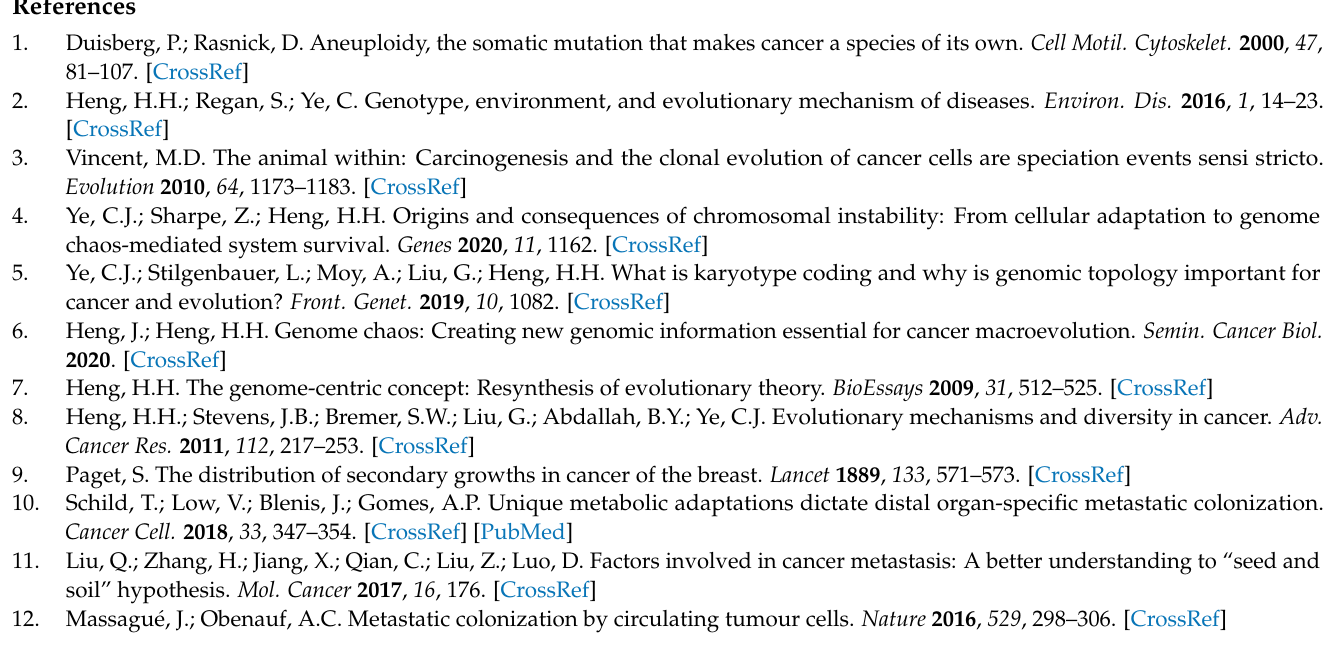
Table S2: Frequency of multiple isPMRCC, Table S3: 5-year survival rates and median survival times following surgical treatment of isPMRCC, Table S4: Distant organ metastases occurring after isPMRCC surgery, Table S5: Frequency of regional LN metastases, Table S6: Liver metastases occurring after isPMRCC surgery, Table S7: Distant organ metastases occurring before isPMRCC